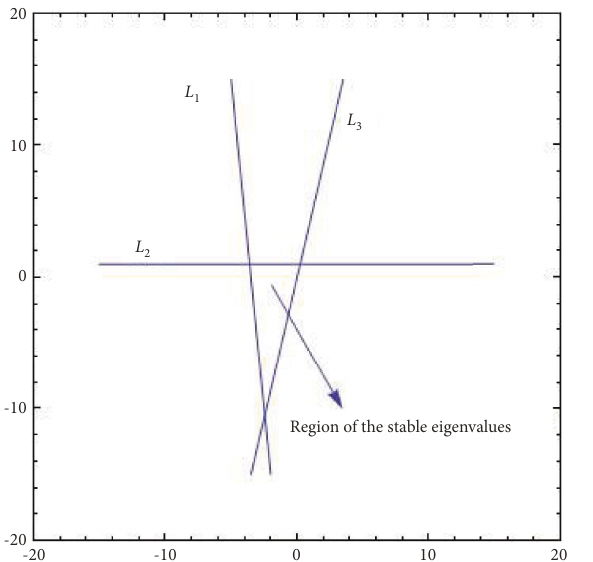
Figure 10: Region of stability where | λ